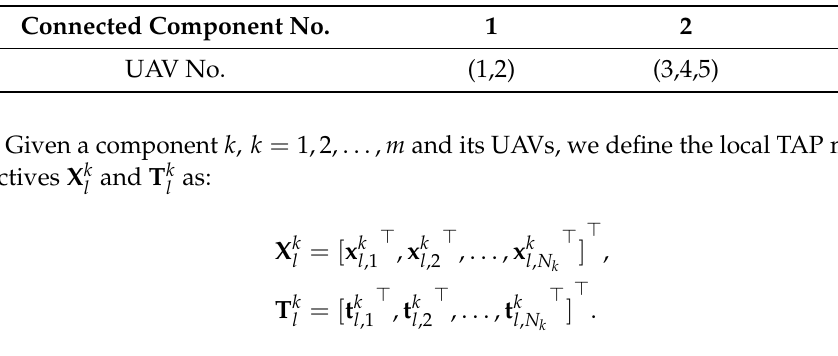
Table 2. Connected component